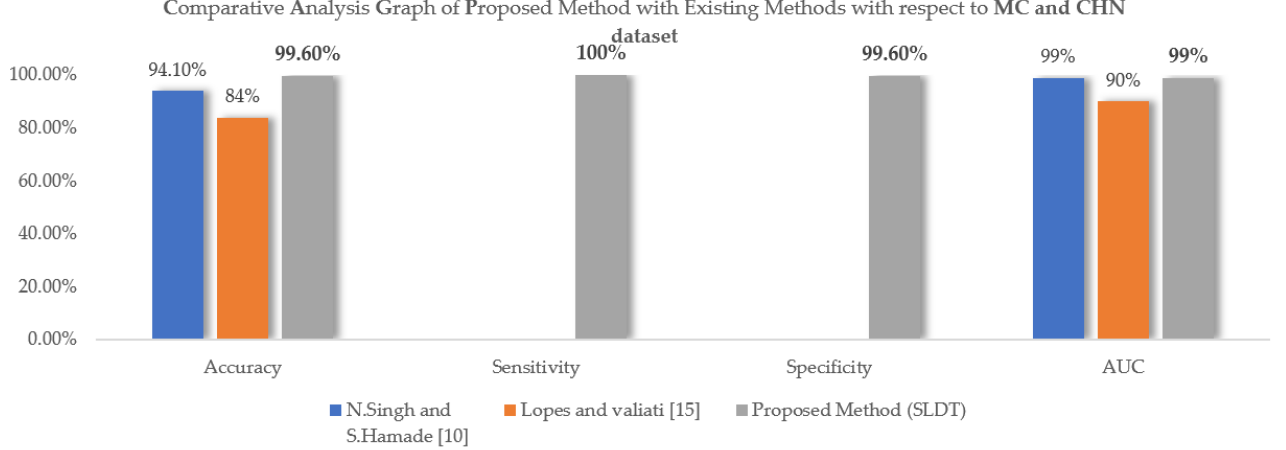
Figure 8. Comparative analysis graph of the proposed method with the existing method with respect to the MC dataset.